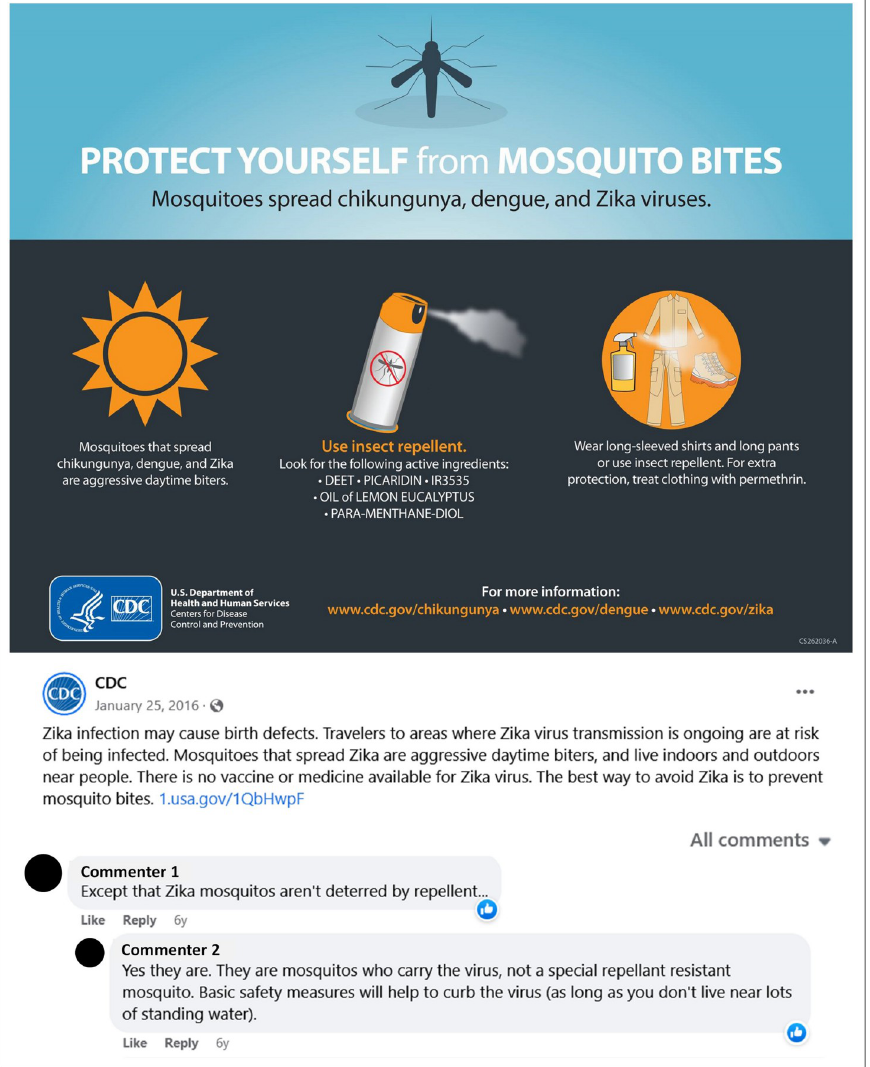
Fig 1. Centers for Disease Control and Prevention Facebook post about mosquito-borne diseases. Source: CDC; Materials developed by CDC). Reference to specific commercial products, manufacturers, companies, or trademarks does not constitute its endorsement or recommendation by the US Government, Department of Health and Human Services, or CDC. Unless a copyright is indicated, information on CDC’s sites, social media profiles, blogs, and applications are in the public domain and may be copied and distributed without